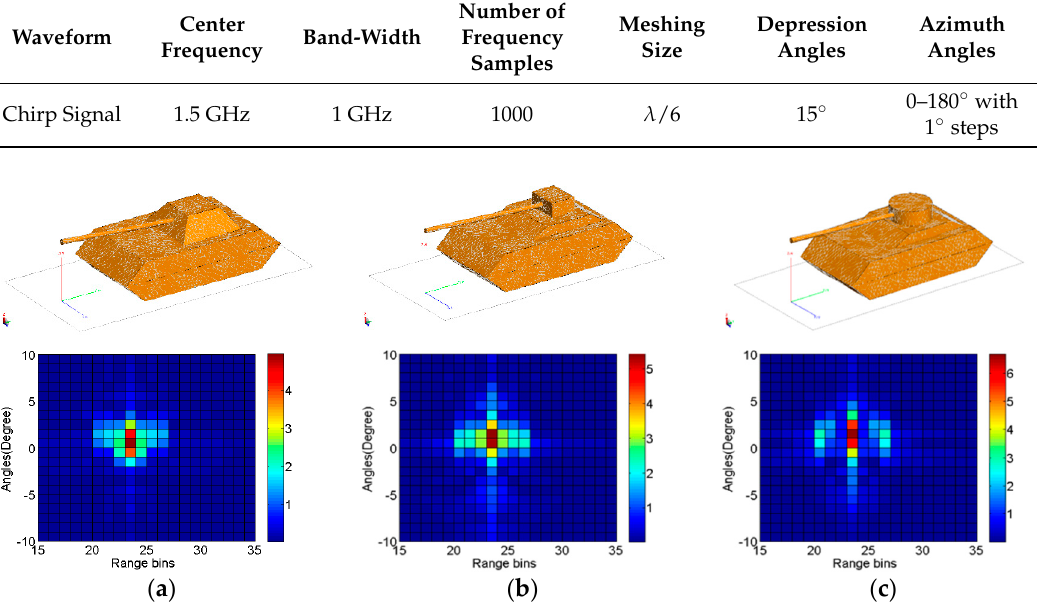
Table 2. Electromagnetic simulation parameters.